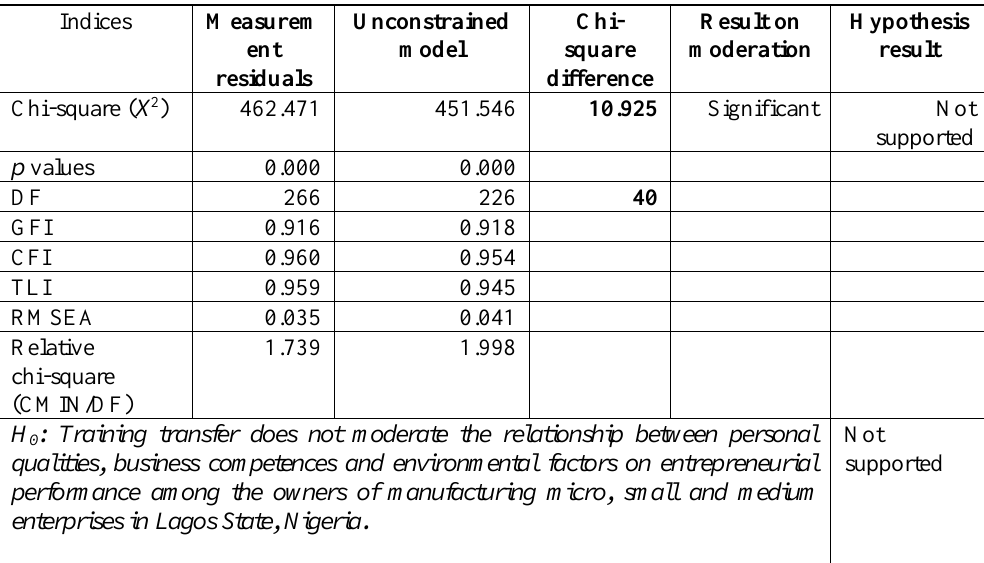
Table 1: The Moderation Test Result using Training Transfer Group Data